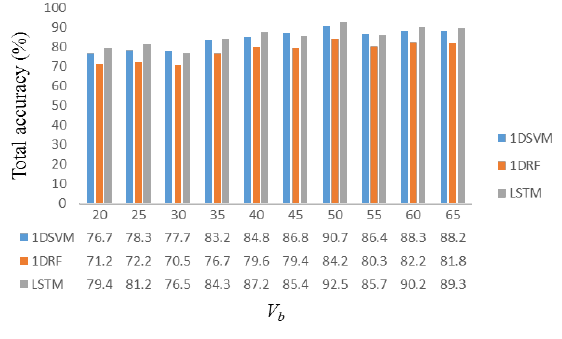
Figure 8: Total accuracy variation for different V b , with V f = V b .